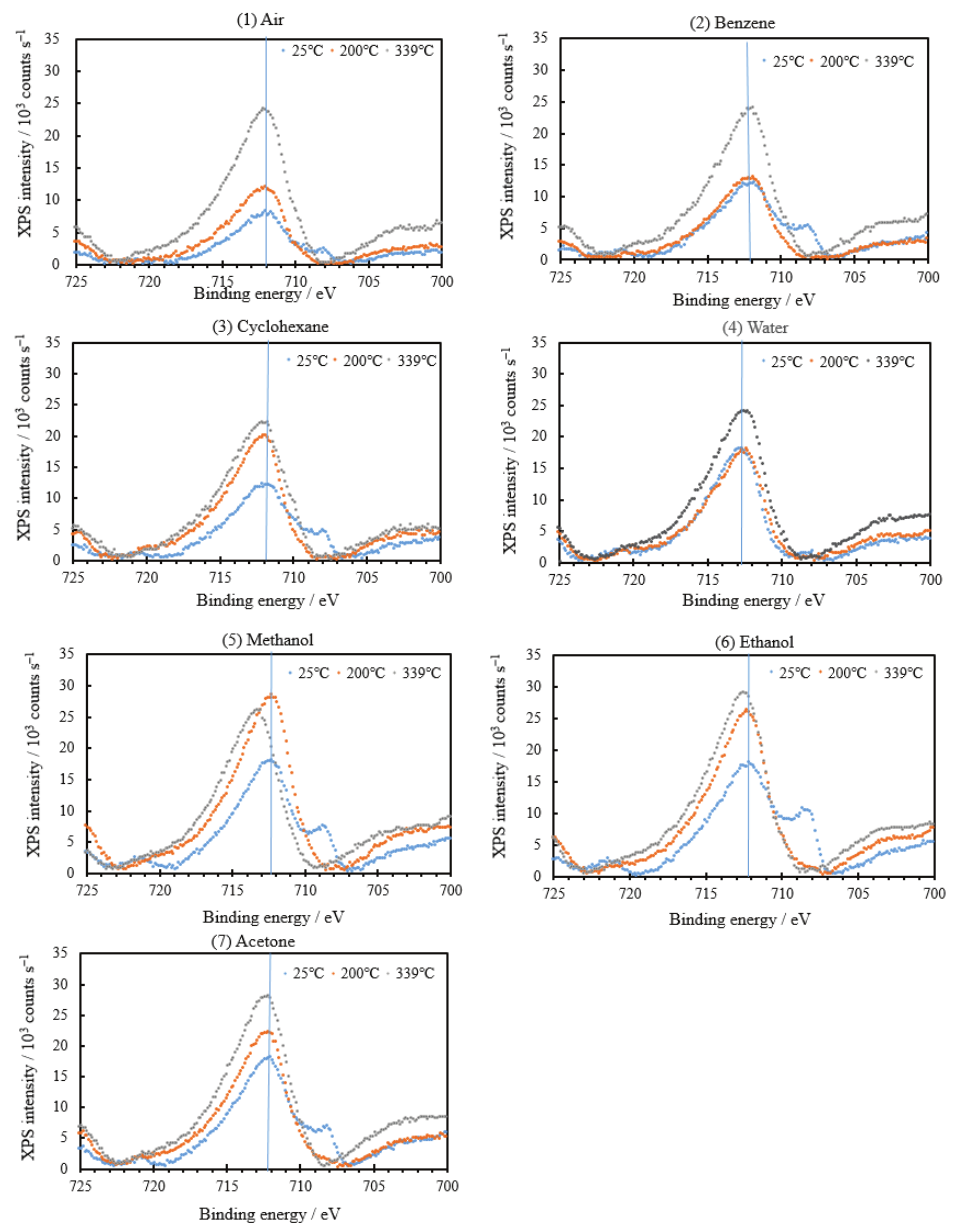
Figure 1. Temperature dependence of Fe 2 p spectra of real iron surfaces scratched in different environments: (1) air, (2) benzene, (3) cyclohexane, (4) water, (5) methanol, (6) ethanol, and (7) acetone. Table 1. The intensities and binding energies of Peaks I, II, and III observed in Fe 2 p spectra at three temperatures for iron surfaces scratched in different environments.